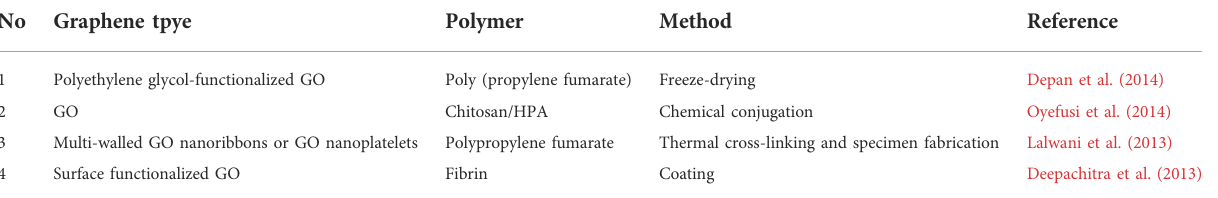
TABLE 5 A list of graphenes with polymers for bone tissue